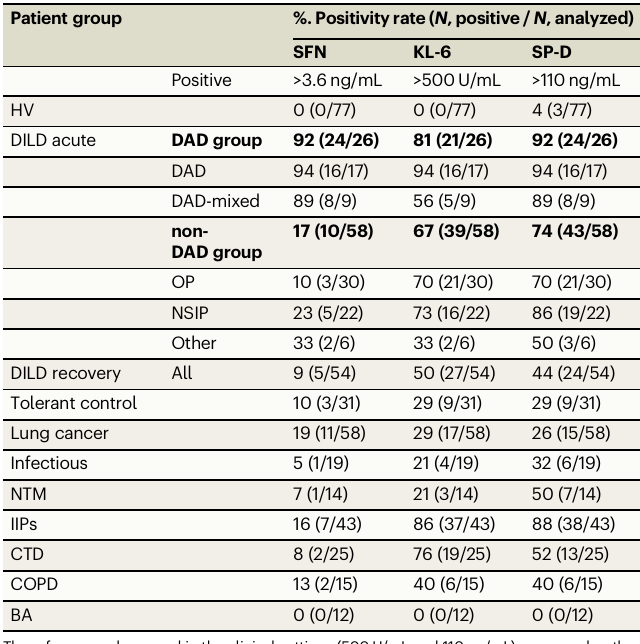
Table 3 | Comparison of the positivity rates for SFN, KL-6, and SP-D in patients with DILD and three types of controls Patient